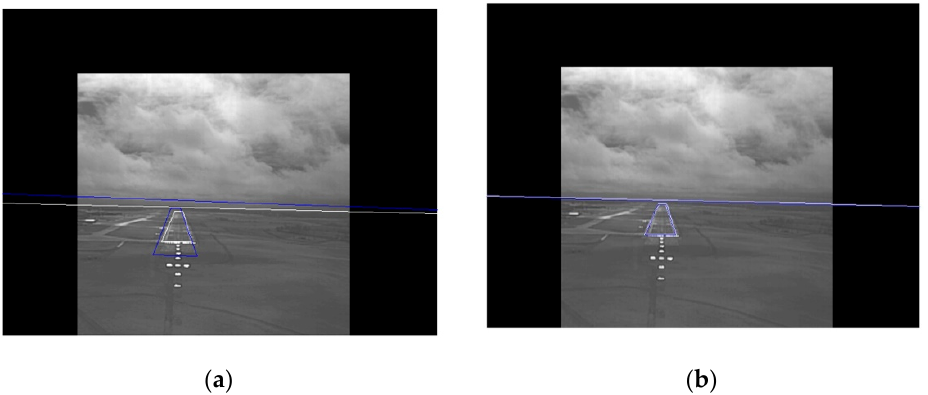
Figure 3. Superimposed SVS horizon and runway onto the EVS image with ( a ) no registration and ( b ) with registration.